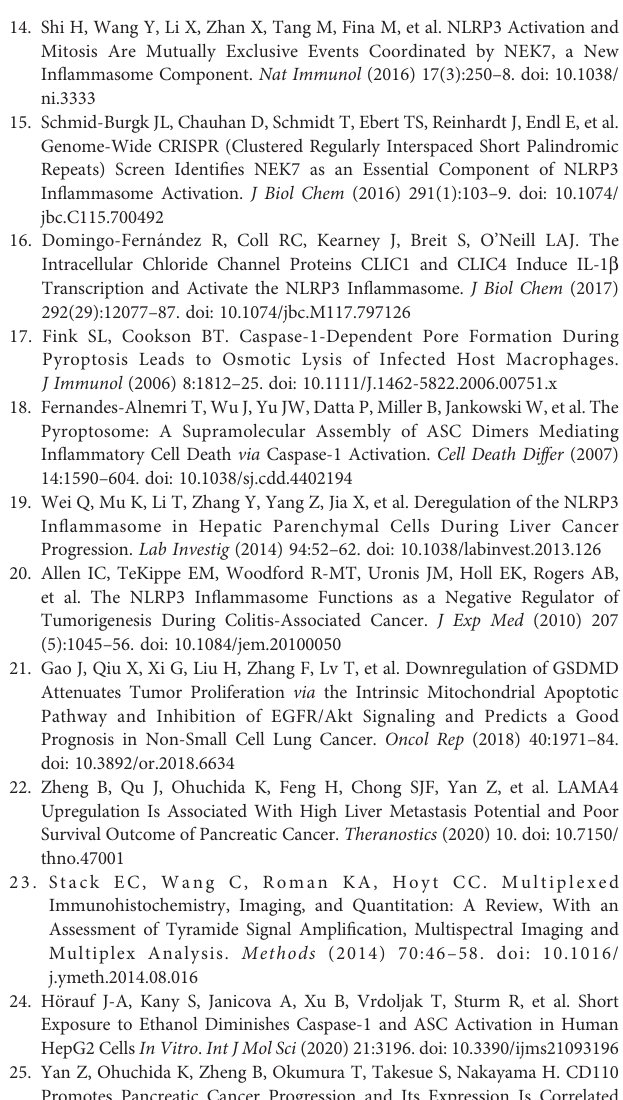
Supplementary Figure 1 | Bioinformatics analysis of NEK7 in hepatocellular carcinoma. (A) Expression of NEK7 signi fi cantly correlated to liver hepatocellular carcinoma cancer histological subtypes. *** P < 0.001, * P < 0.05. (B) Correlation between NEK7 expression and NLRP3, IL-18, GSDMB, GSDMC expression in HCC tissues. (C) Co-expression of NEK7 (green) and GSDMD (red) by multiple fl uorescent immunohistochemical staining of HCC specimen. Scale bars = 100 m m. Supplementary Figure 2 | co-expression of NEK7 and GSDMD in HCC specimens. (A) mIHC staining of NEK7 and GSDMD on HCC specimens. (B) Co- expression of NEK7 and GSDMD was observed on serial sections of HCC